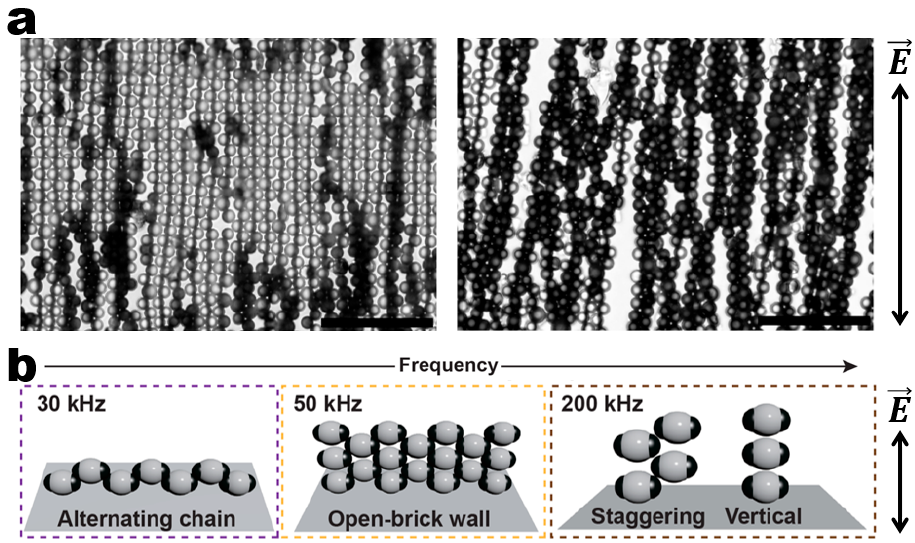
Figure 7. Field-driven dynamic structuring of Janus and patchy particles. ( a ) Assembly of metallo- dielectric Janus particles into (left) staggered chains and (right) 3D bundles in a planar AC electric fi eld. Scale bars: 50 µm. Reproduced with permission [56]. Copyright 2008, American Chemical Society. ( b ) Frequency-dependent dynamic structuring of metallo-dielectric patchy particles [58]. Copyright 2021, American Chemical Society.